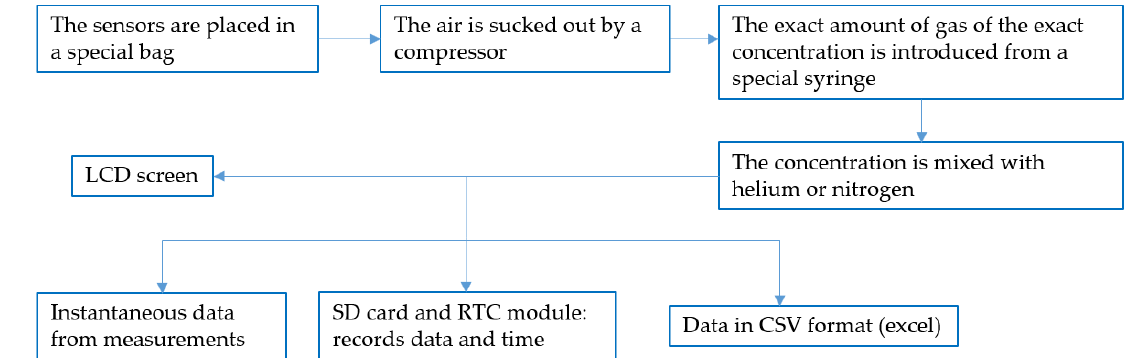
Figure 5. Explanatory diagram for obtaining calibration data in the laboratory. Twelve-point tables with increasing known CH 4 concentrations and other gases were compiled for each sensor. The values were in a range of 100k ppm up to 500k ppm. Each gas concentration was compared to the decimal analogue value obtained over an average of several 300 s readings. Three test sessions were performed at different concentrations of CH 4 and He as the background